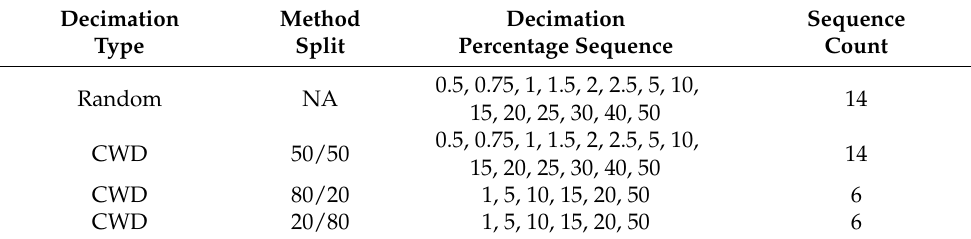
Table 1. Summary of decimation run suites made on each of the six panels of the decimation study.